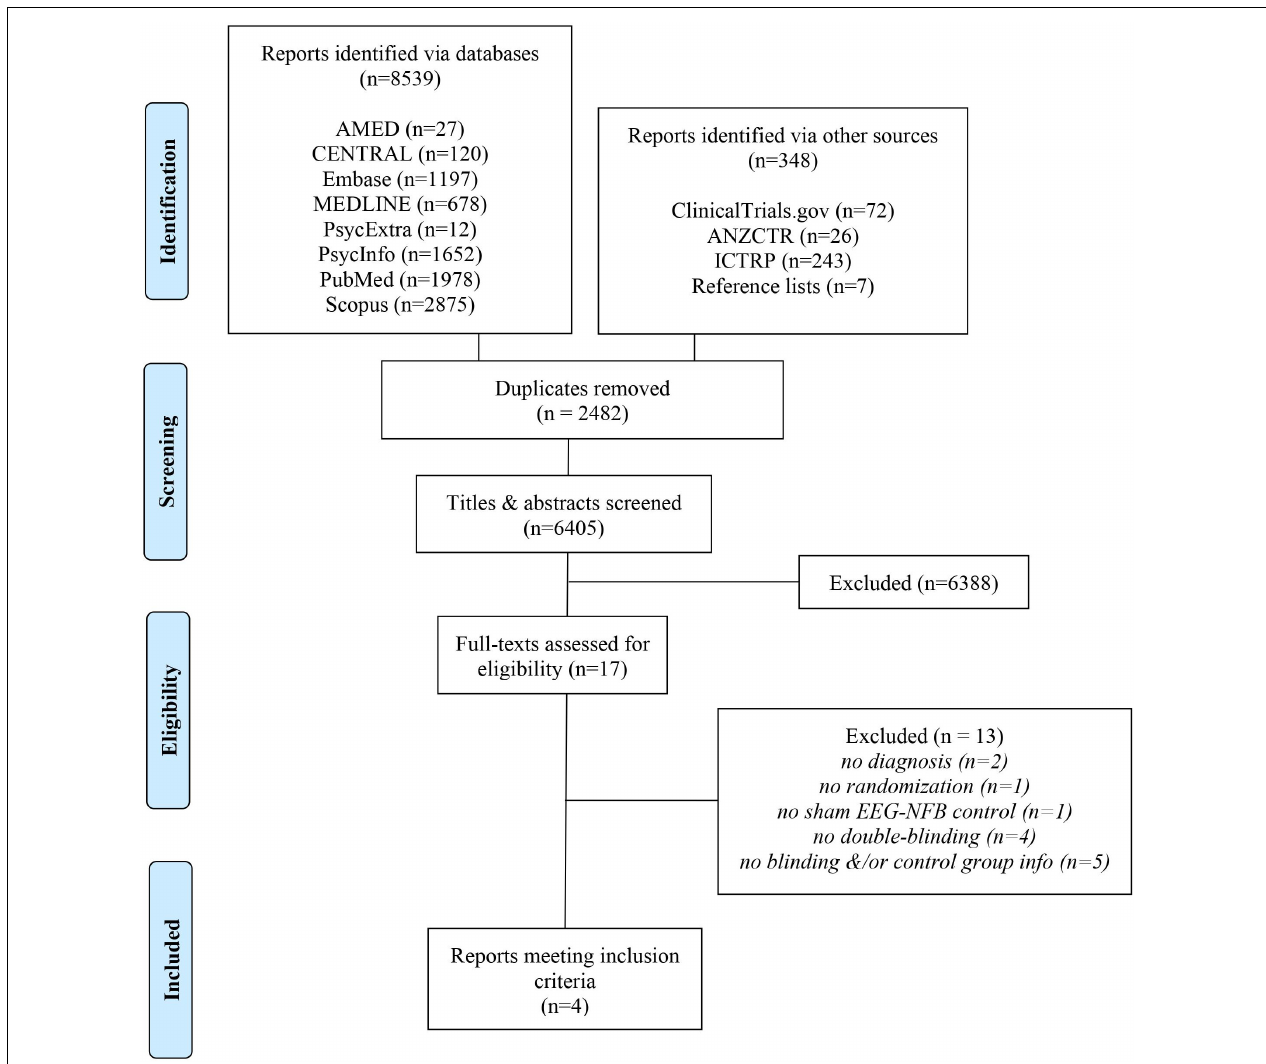
FIGURE 1 | Flow of screening and selection of